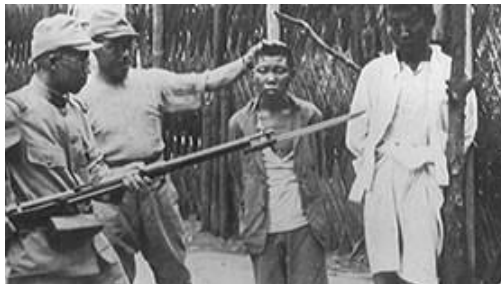
Figure 10. Japanese abuse young Chinese captives. Source: LOOK